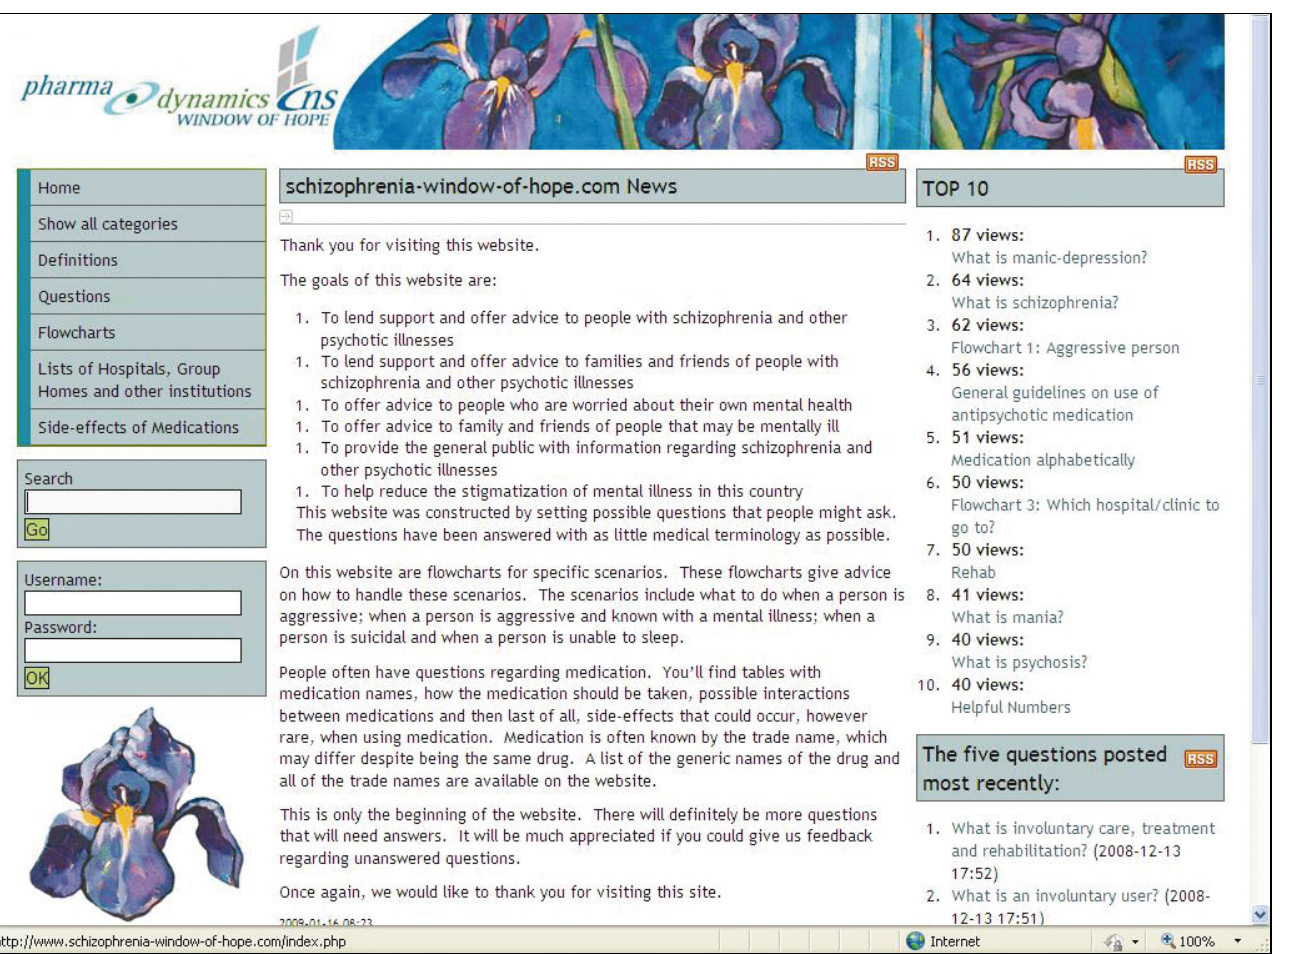
Fig. 1. Home page,